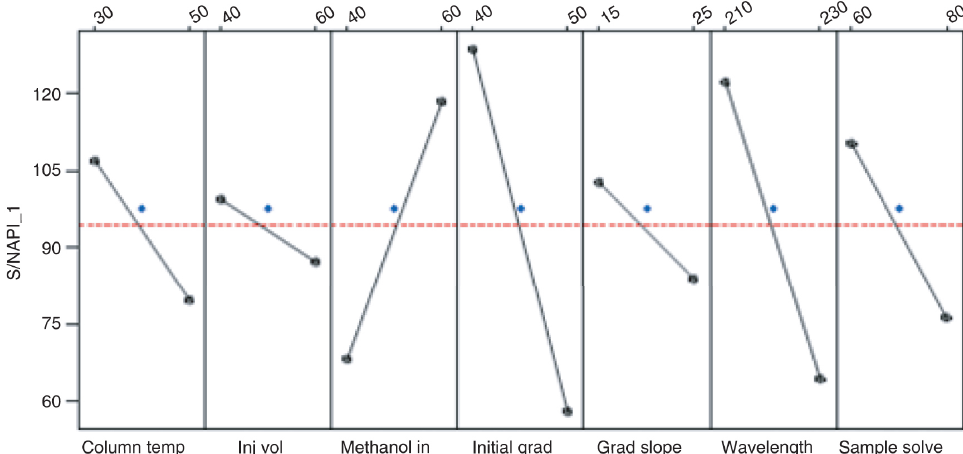
Figure 13: Main effect plots generated by MINITAB to predict the effect of variables placed on the x -axis on chromatographic sensitivity (Li and Rasmussen